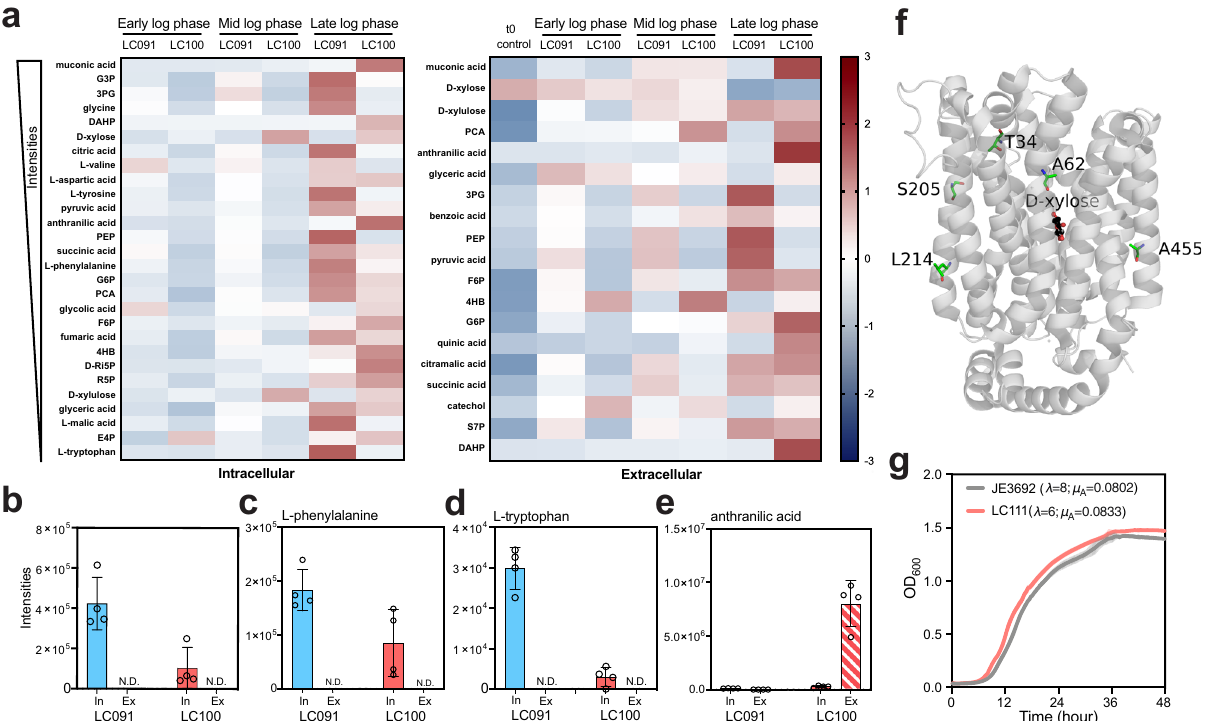
Fig. 3 | Characterizing mutations in the promoter region of PP_2569 and XylE. a Heatmapoftheselectedintracellularandextracellularmetabolites.Z-scoreswere calculated using the average intensities of intracellular and extracellular metabo- lites separately, and a time zero control from uninoculated medium was also included for extracellular metabolite analysis. b – e Intensities of selected metabo- litesfrom late log phase, “ In ” representsintracellular, “ Ex ” represents extracellular, and “ N.D. ” represents not detected. The intracellular intensity signal was collected